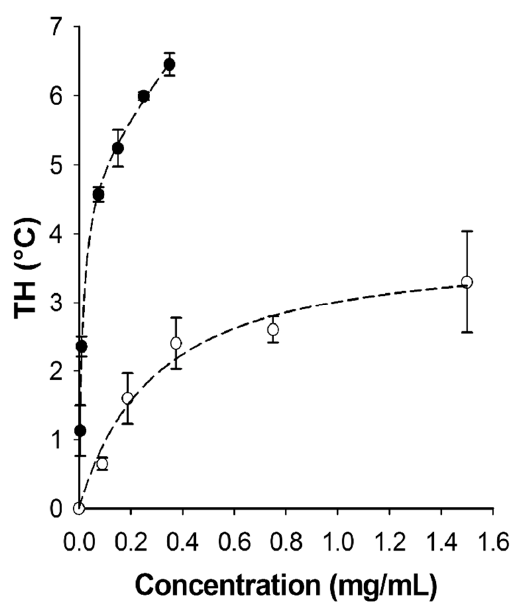
Figure 6. Antifreeze activity comparison of ice-affinity-purified native Tm AFP and a recombinantly expressed single isoform (4-9). Thermal hysteresis (TH) in °C is plotted as a function of protein concentration (mg/mL). The values for 4-9 (open circles) were taken from Marshall et al., 2002 [23]. The values for the ice-affinity purified natural Tm AFP isoform mixture (solid circles) were obtained in this study. TH readings were done in triplicate and error bars represent ± SD.